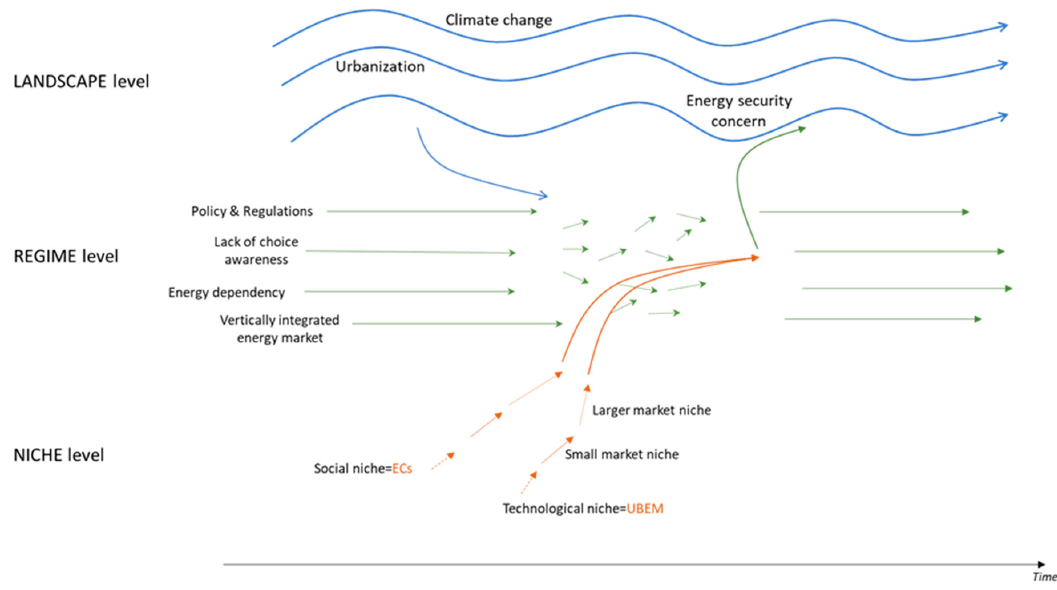
Figure 1. Positioning research subject in the multi-level perspective—adapted figure of Geels [64].